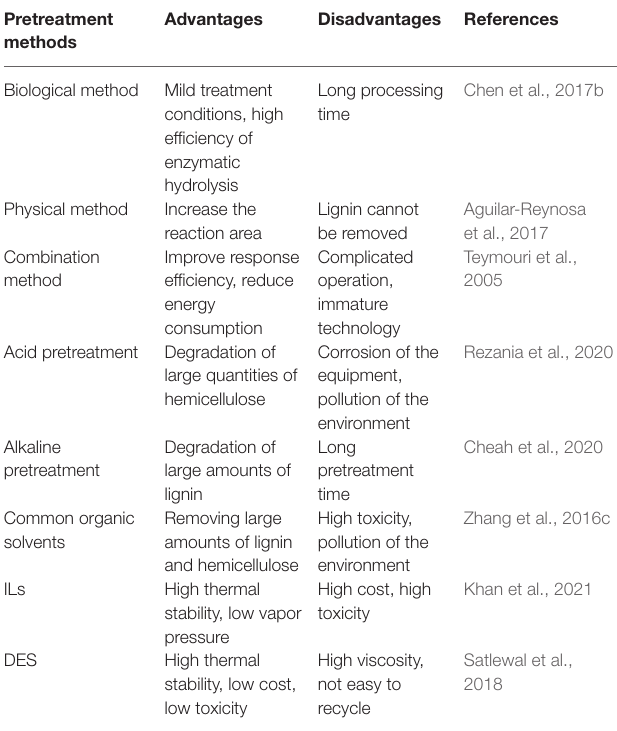
TABLE 1 | The advantages and disadvantages of traditional pretreatment